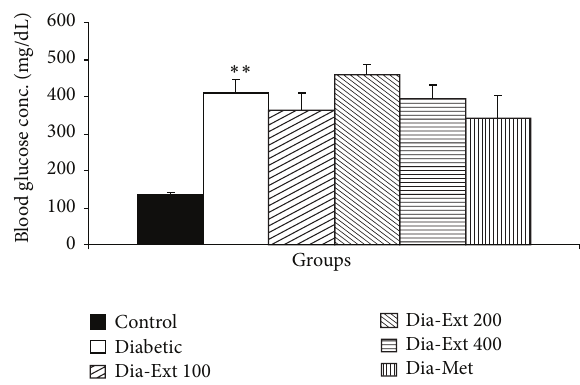
Figure 6: The blood glucose concentrations of 6 groups. Data are shown as mean ± SEM of 10 animals per group. ∗∗ 𝑃 < 0.01 in comparison with Control